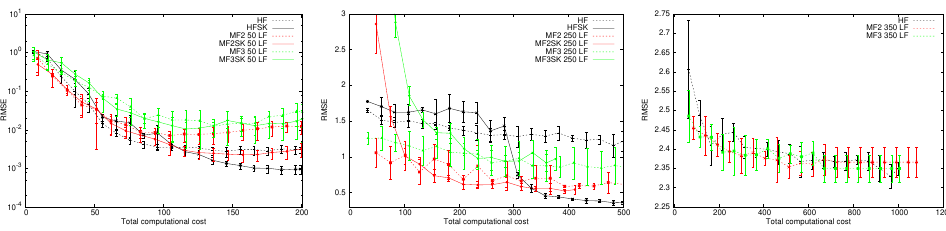
Figure 14. Kriging: Rastrigin function RMSE (from left to right, two, five and ten dimensions). Ordinary and SPCE-Kriging in dashed and solid lines, respectively.